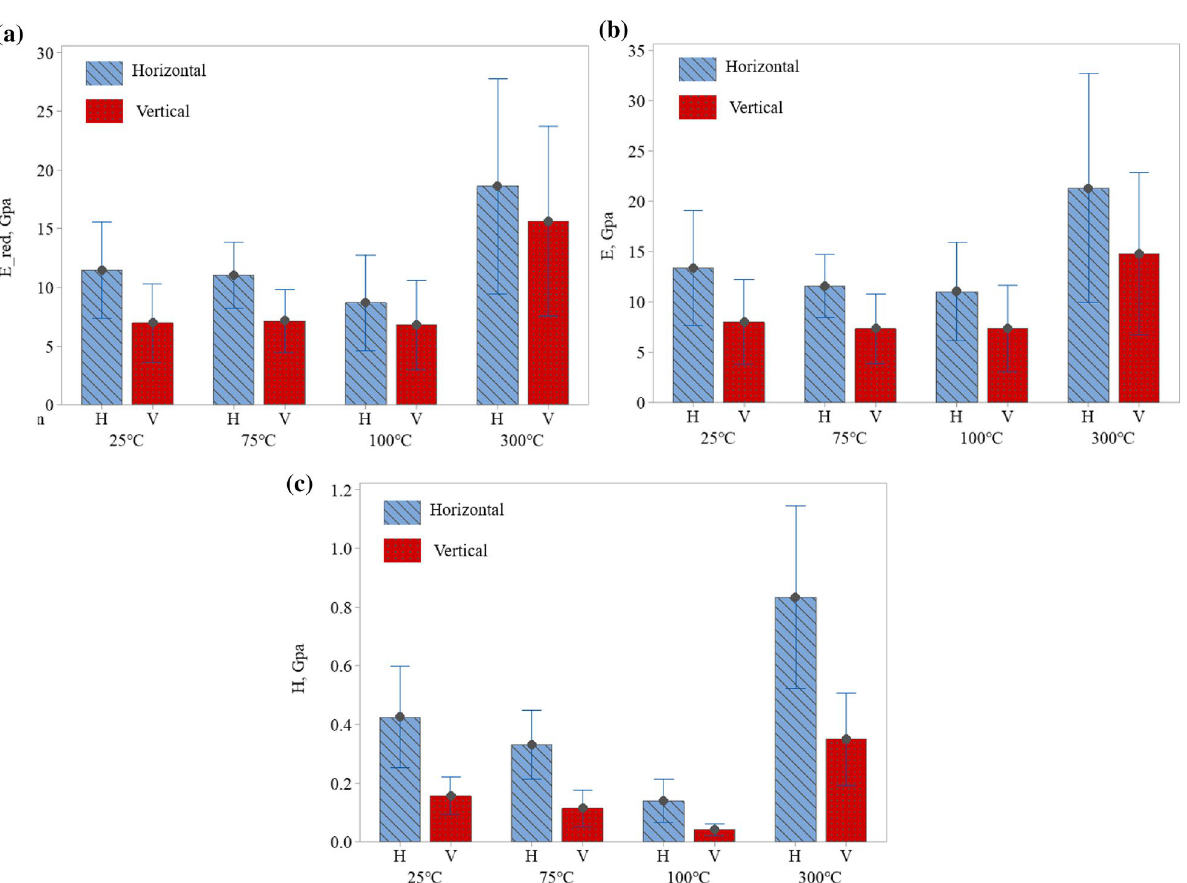
Figure 3. ( a ) Reduced modulus for both vertical and horizontal bedding planes in elevated temperatures. ( b ) Elastic modulus for both vertical and horizontal bedding planes in elevated temperatures. ( c ) Hardness values for both vertical and horizontal bedding planes in elevated